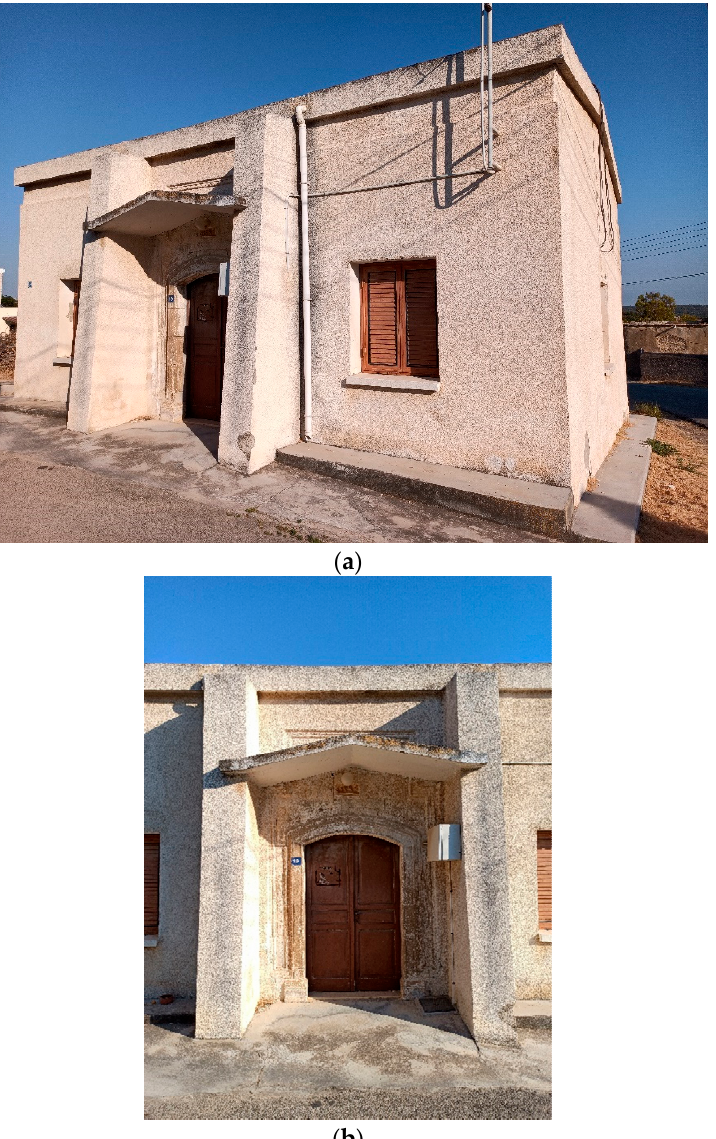
Figure 4. ( a,b ): Yedikonuk/Ephtakomi, former mosque (vernacular type), currently used as an educational space, 1884 (photos: authors).